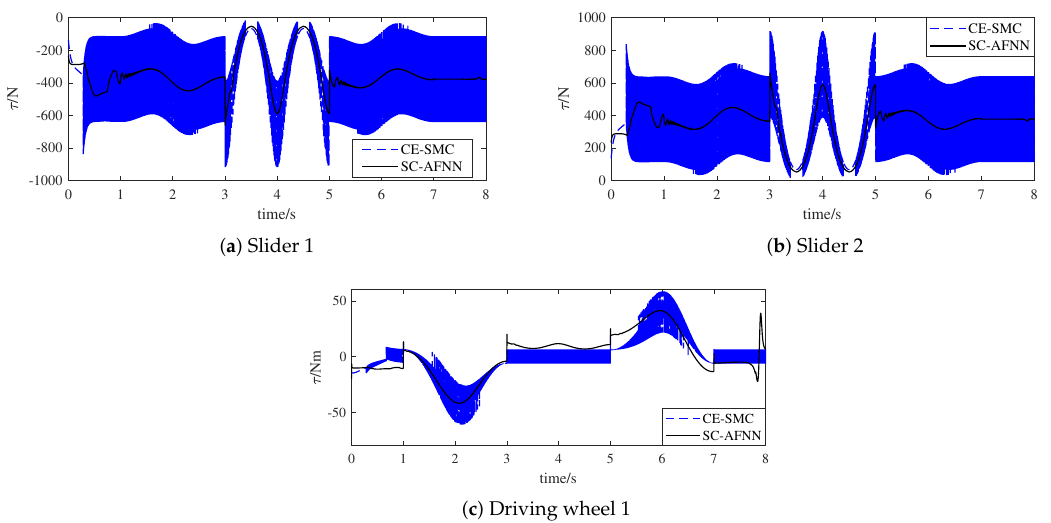
Figure 6. The output torque curves. ( a ) Driving torque of slider 1; ( b ) Driving torque of slider 2; ( c ) Driving torque of driving wheel 1.